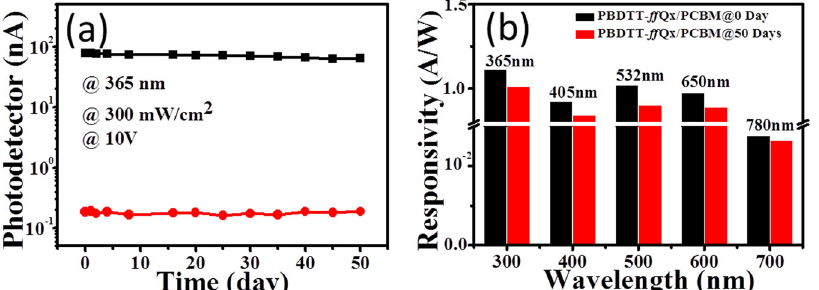
Fig. 6 a Photocurrent and dark current of PBDTT- ff Qx/PCBM BHJ photodetector measured in ambient condition for exposing 50 days. b The R values of the PBDTT- ff Qx/PCBM BHJ photodetector in the UV – Vis regions in ambient condition at the original state and after exposing for 50